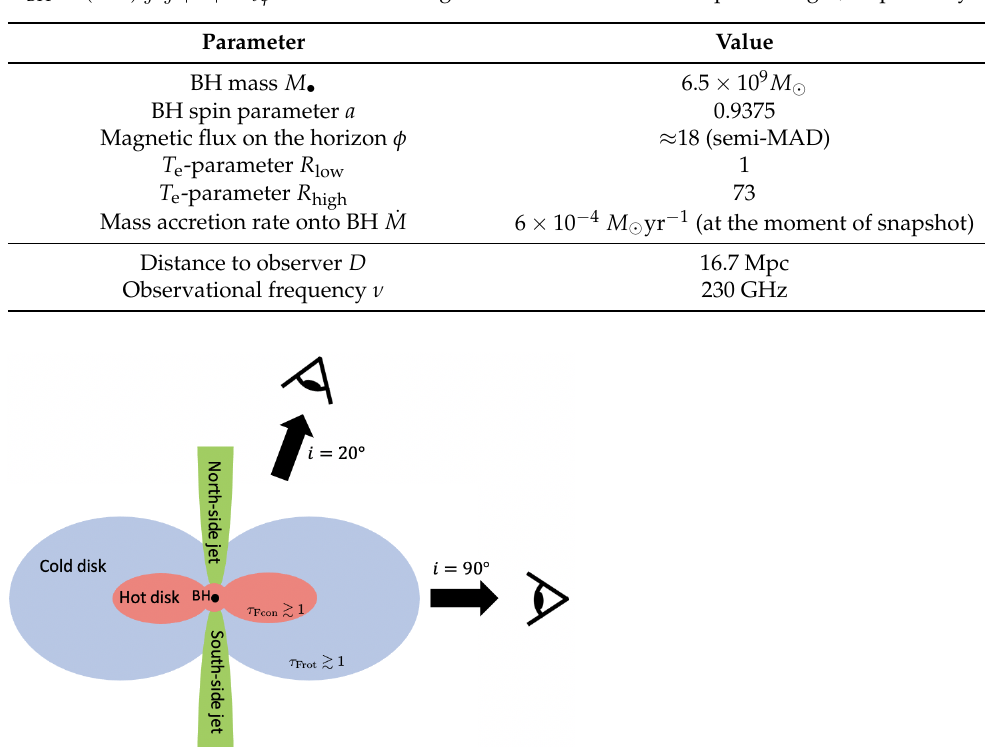
Table 1. Parameters in our GRMHD and GRRT model, following a fiducial model in [18], ex- cept the observer’s inclination angle. Here, M (cid:12) is the solar mass. φ ≡ Φ BH / strength of dimensionless magnetic flux on the event horizon of SMBH, where r g ≡ GM • / c 2 and